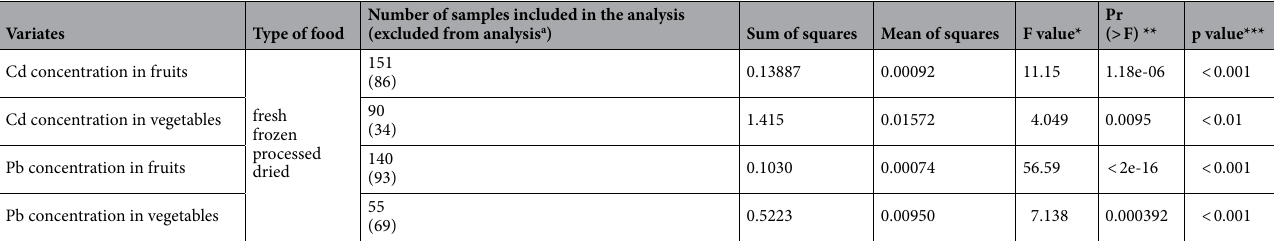
Table 8. Analysis of variance (ANOVA) for variates in four groups. a Deleted due to value below the LOQ of